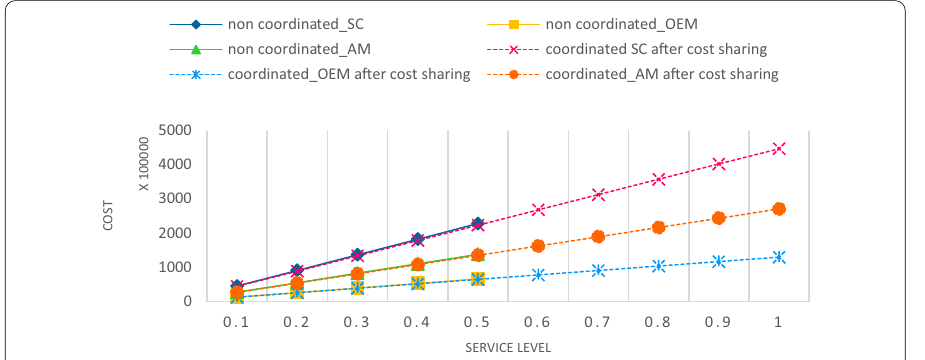
Fig. 4 The differences between the costs of OEM, AM, and the supply chain in the non-coordinated scenario and the coordinated scenario after applying the cost-sharing mechanism. Note: For the service levels more than 0.5, the problem is infeasible for the non-coordinated scenario, that is, infinity costs)